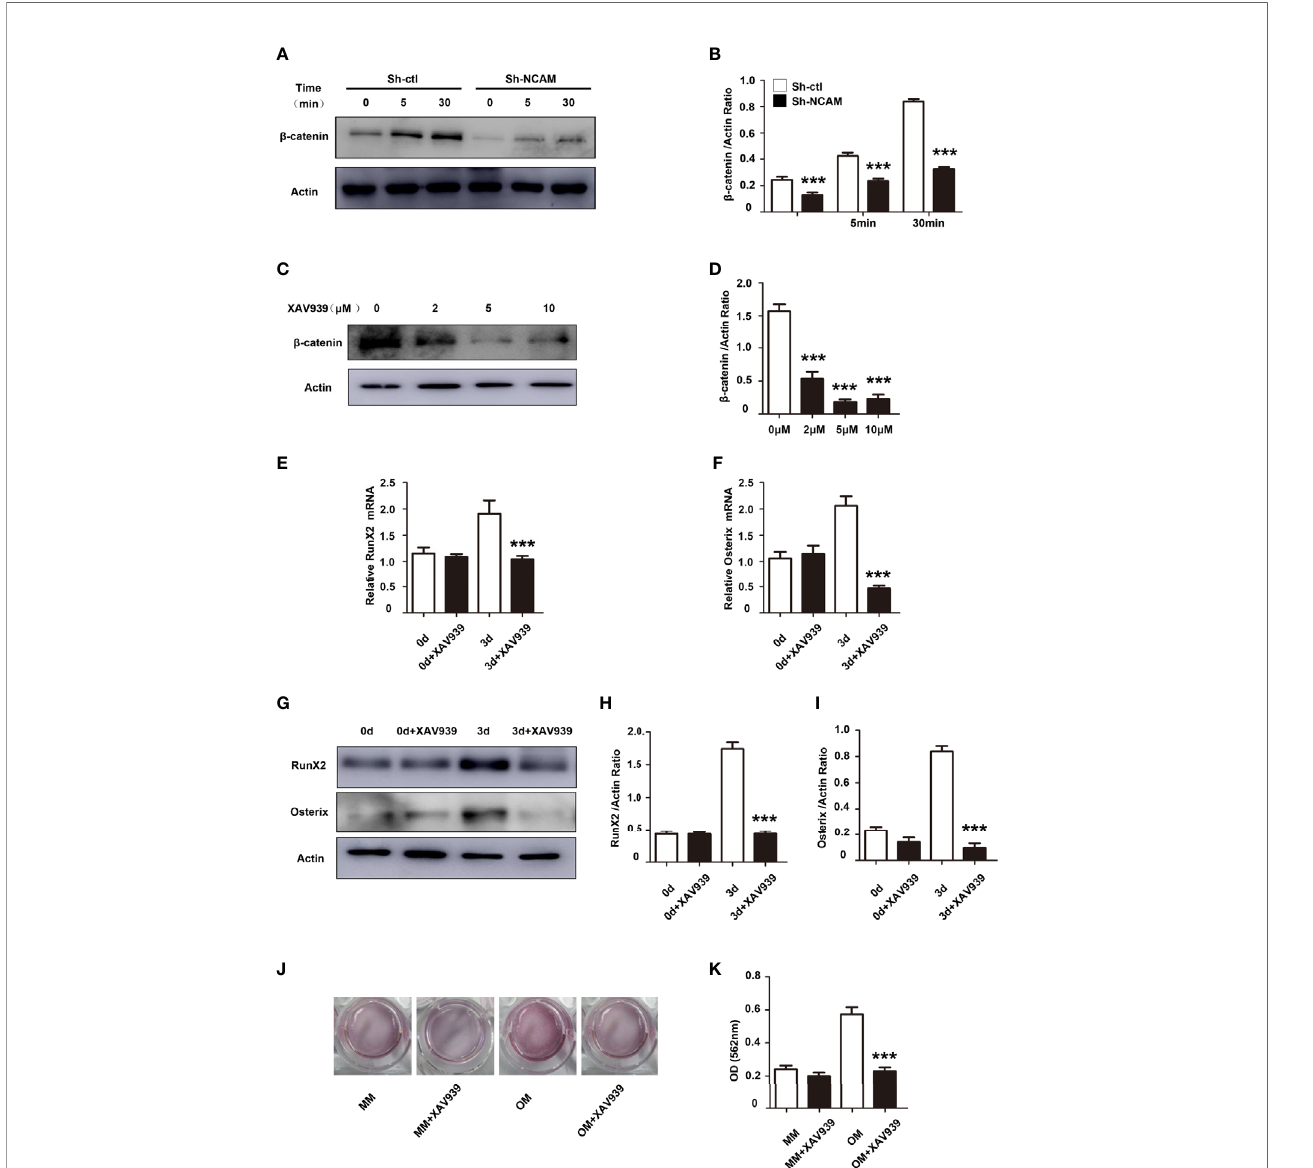
FIGURE 3 | Inhibition of Wnt/ b -catenin signaling inhibits osteoblast differentiation. (A) Sh-ctl and Sh-NCAM MC3T3-E1 cells were treated with differentiation media for 0, 5, and 30 min, the expression of b -catenin was analysed by immunoblotting. b -actin was detected as a loading control. (B) Level of b -catenin was quanti fi ed by densitometry and normalized to b -actin (n=3; mean ± SEM; *** p < 0.001, compared with control siRNA group). MC3T3-E1 cells were pretreated with the Wnt inhibitor XAV939. (C) The expression of b -catenin was analysed and (D) quanti fi ed by densitometry and normalized to b -actin (n=3; mean ± SEM; *** p < 0.001, compared with cells without XAV939). The expressions of (E) RunX2 and (F) Osterix were examined by real-time PCR (The results are expressed as the mean ± SEM of three independent experiments. *** p < 0.001, compared with cells without XAV939). (G) The expressions of RunX2 and Osterix were analysed by immunoblotting, b -actin was detected as a loading control. Levels of (H) RunX2 and (I) Osterix were quanti fi ed by densitometry and normalized to b -actin (Data are representative of three independent experiments and values are means ± SEM. *** p < 0.001, compared with cells without XAV939). (J) Calcium deposition was assessed by Alizarin red staining. (K) The Alizarin red staining was extracted and quanti fi ed, the wavelength was measured at 562 nm (Data are representative of three independent experiments and values are means ± SEM. *** p < 0.001, compared with cells without